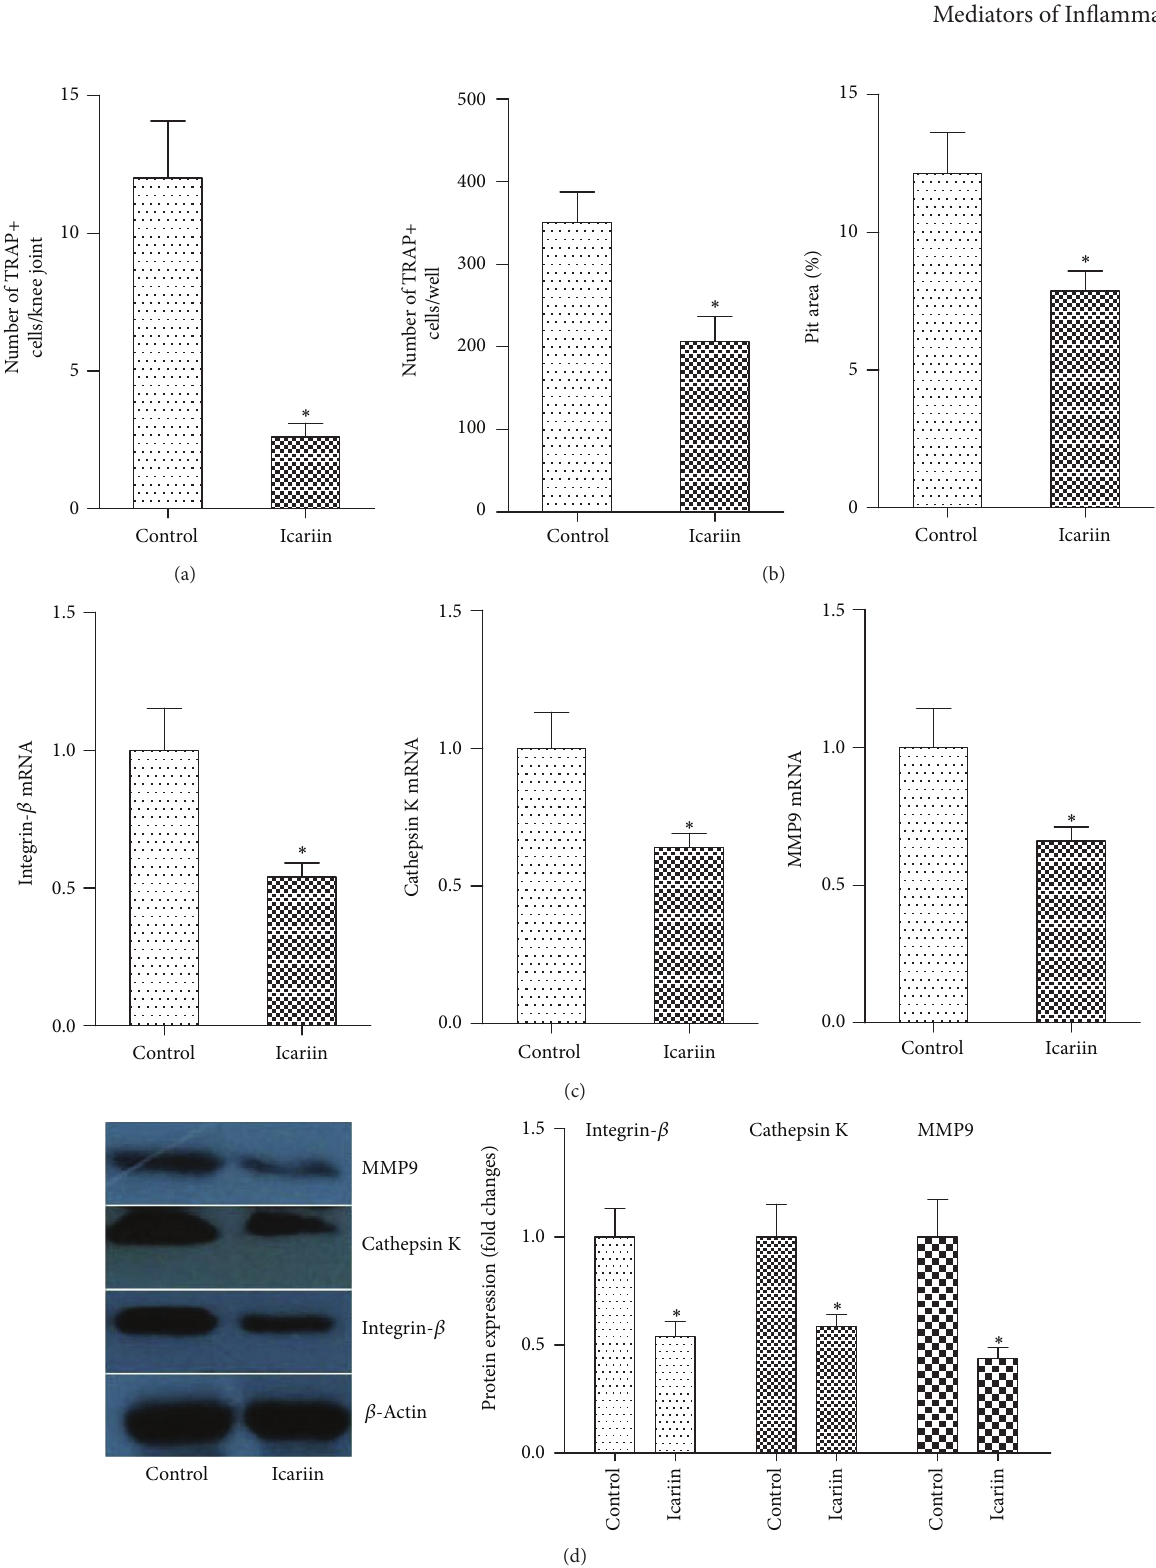
Figure 4: Icariin inhibits osteoclastogenesis in mice. (a) The number of TRAP + cells in synovial tissue sections from the joints of mice with CIA. (b) Osteoclast precursor cells from bone marrow-derived monocytes/macrophage (BMM) cells of normal mice were further cultured in the presence of M-CSF (10ng/mL) together with RANKL (50ng/mL) with or without icariin. The number of TRAP + cells and percentage of pit area were determined. (c) The mRNA expression of various osteoclastogenic markers was analyzed using real-time PCR. (d) The protein level of various osteoclastogenic markers was analyzed using Western blot. ∗ 𝑃 < 0.05 versus all other groups. 𝑛 = 6